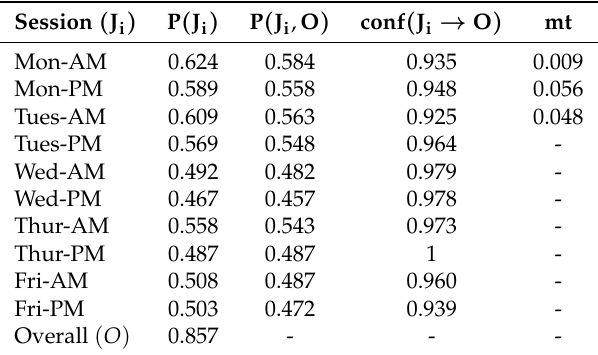
Table 4. Identifying target sessions—2015/2016, T t =